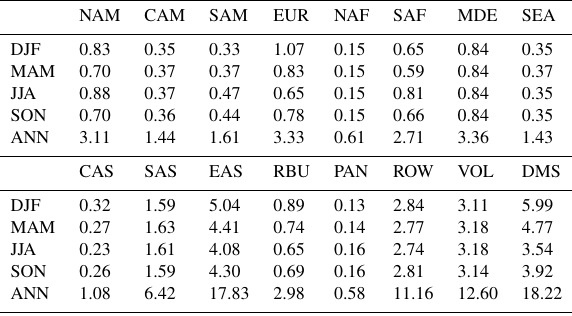
Table 1. Annual and seasonal total emissions (unit:TgS) of combustion (anthropogenic + biomass burning) SO 2 and DMS from the 16 source regions/sectors in December–January–February (DJF), March–April–May (MAM), June–July–August (JJA),